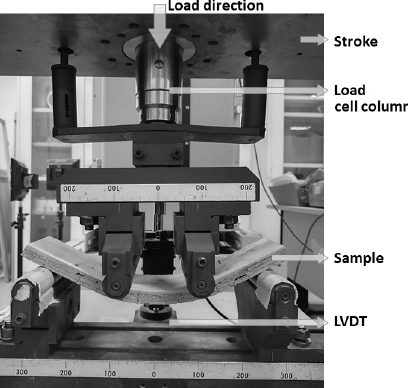
Figure 13. Four-point bending test of XSBR-coated jute fabric composite.